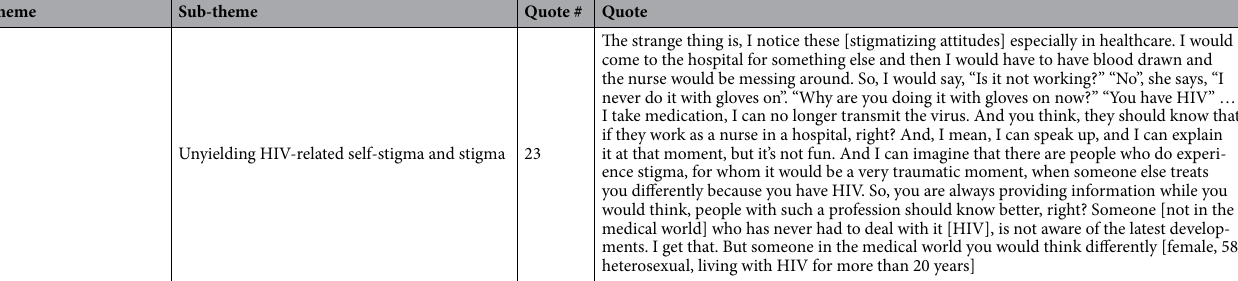
Table 3. Quotes supporting how life is dominated by